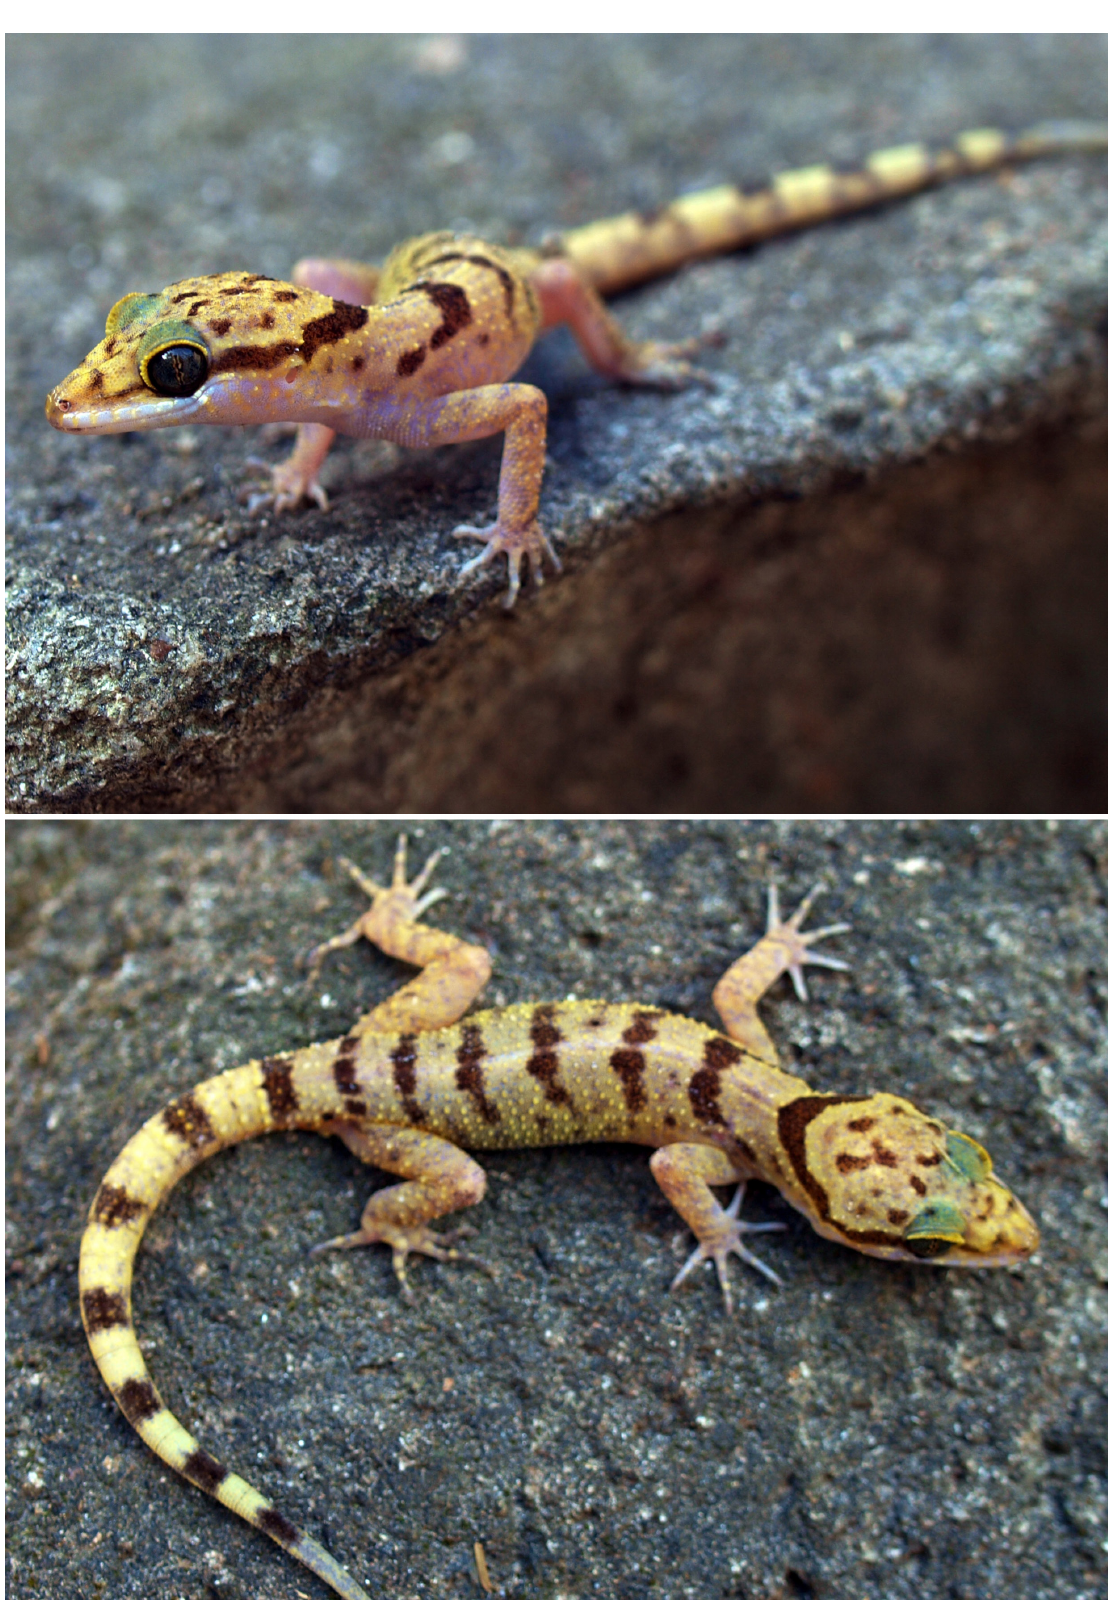
Fig. 4. Cyrtodactylus chungi sp. nov., in life paratype, ♀ (IEBR 4582). Photos T.M.